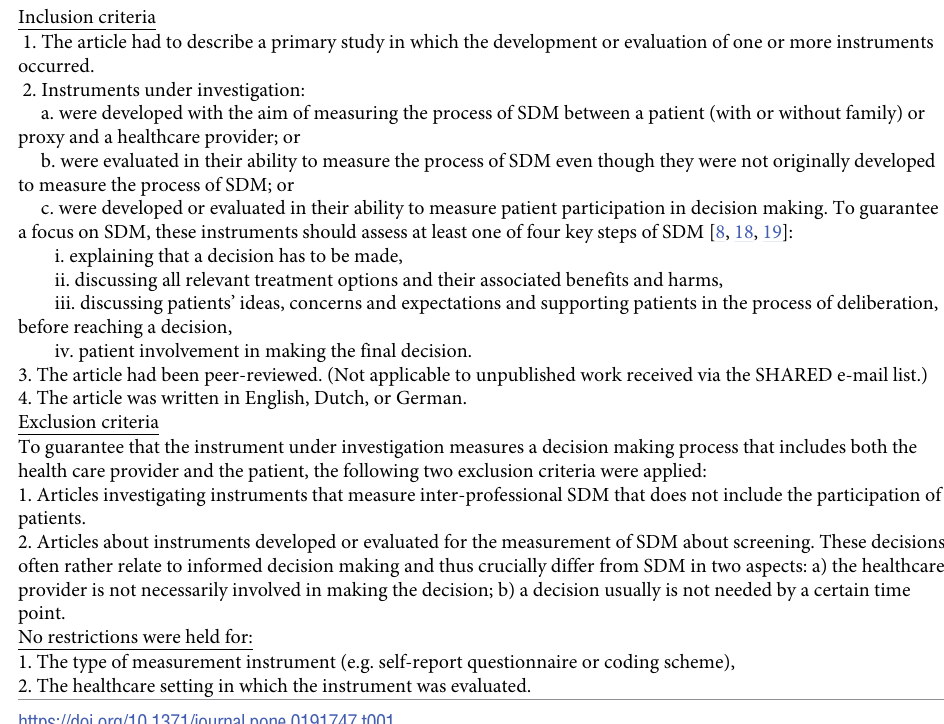
Table 1. Eligibility